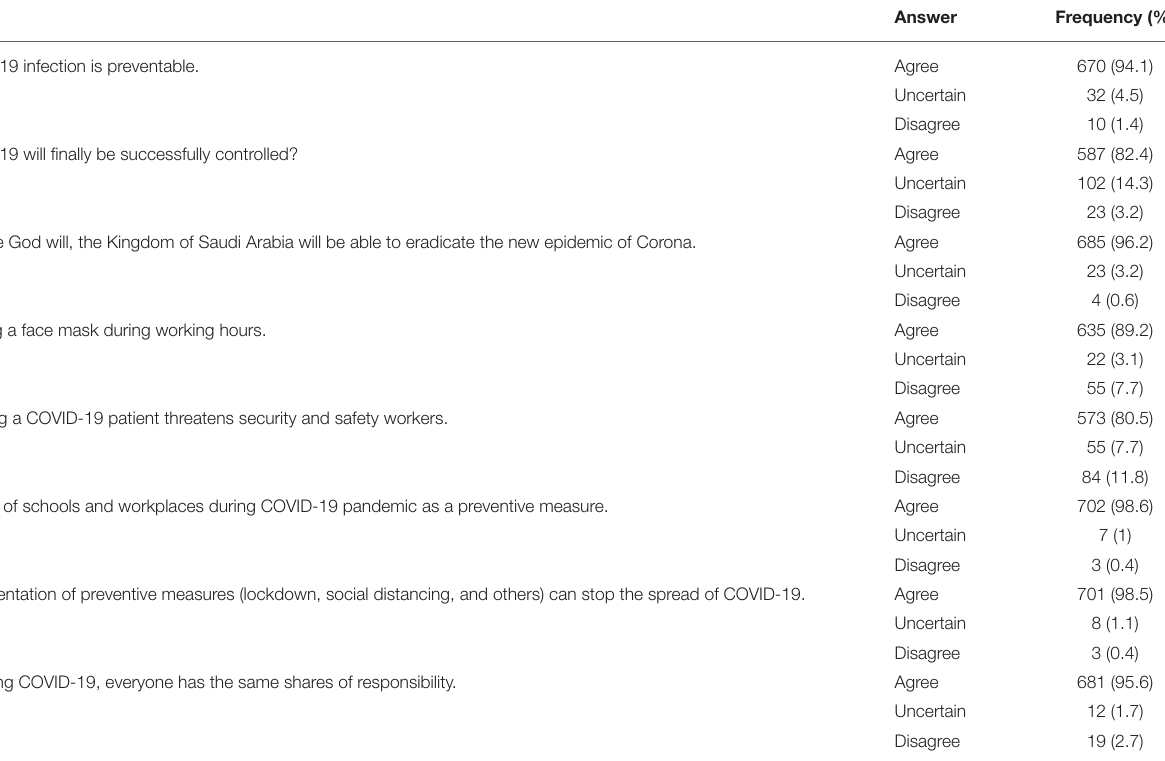
Table 4 | Distribution of participant response to attitude related questions on COVID-19 ( N =